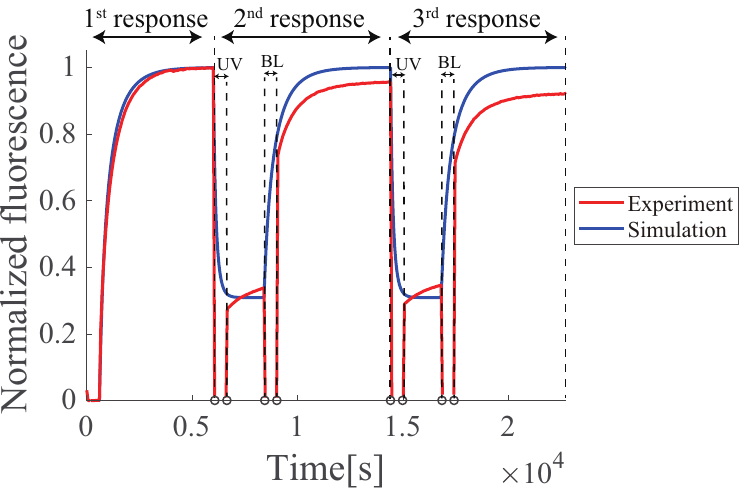
Figure 11. Multiple operations of azo-degradation. The red line shows the experimental re- sults, and the blue line shows the simulation results. The simulation uses the reaction rates of k s 1 = 1.45 × 10 − 6 nM − 1 s − 1 , k s 2 = 1.35 × 10 − 5 nM − 1 s − 1 . The experiment was conducted